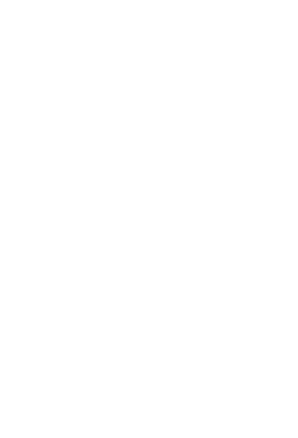
Table 2. Design parameters for each specimen